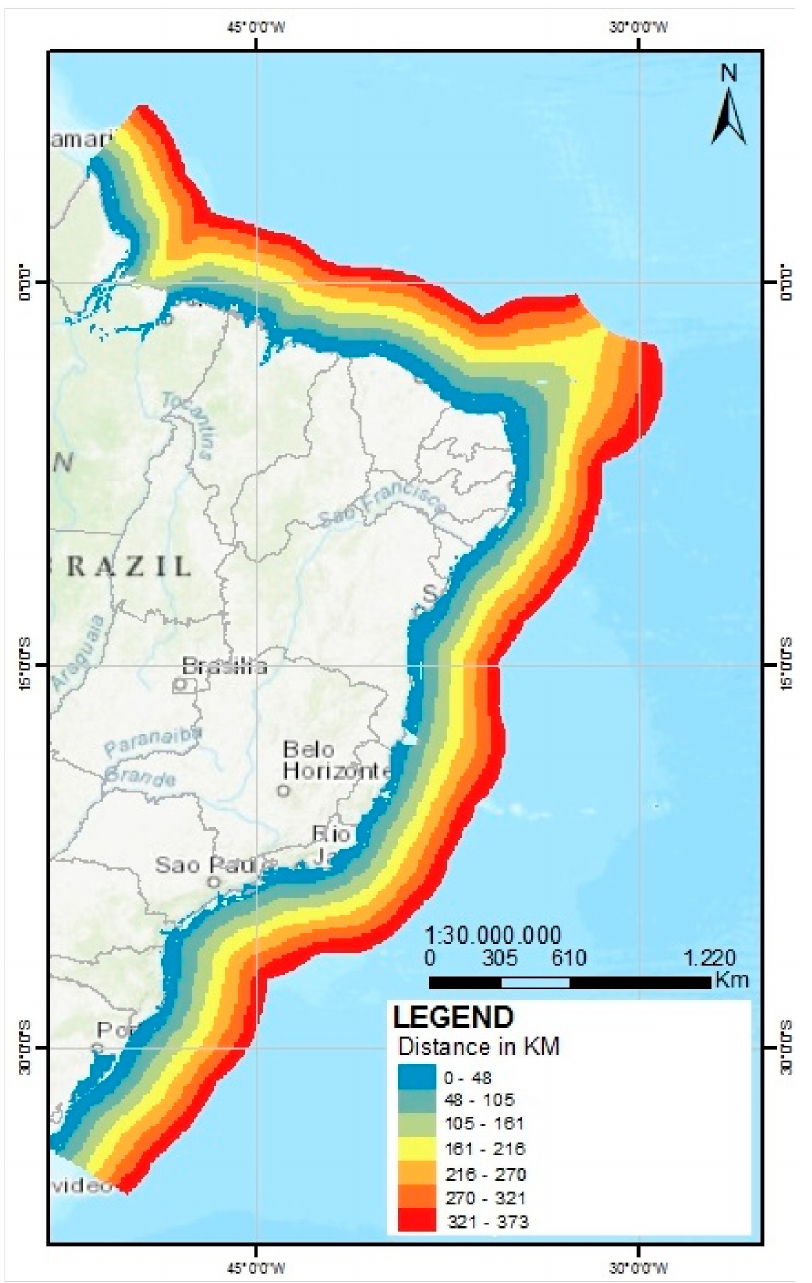
Figure 5. Distance from the coast represented in